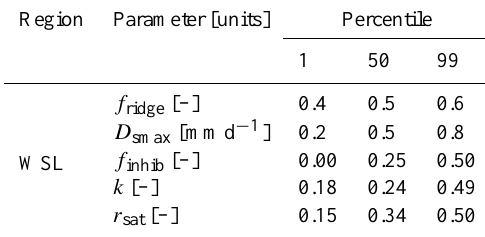
Table 2. Posterior distributions of calibrated parameters for hydrol- ogy and soil